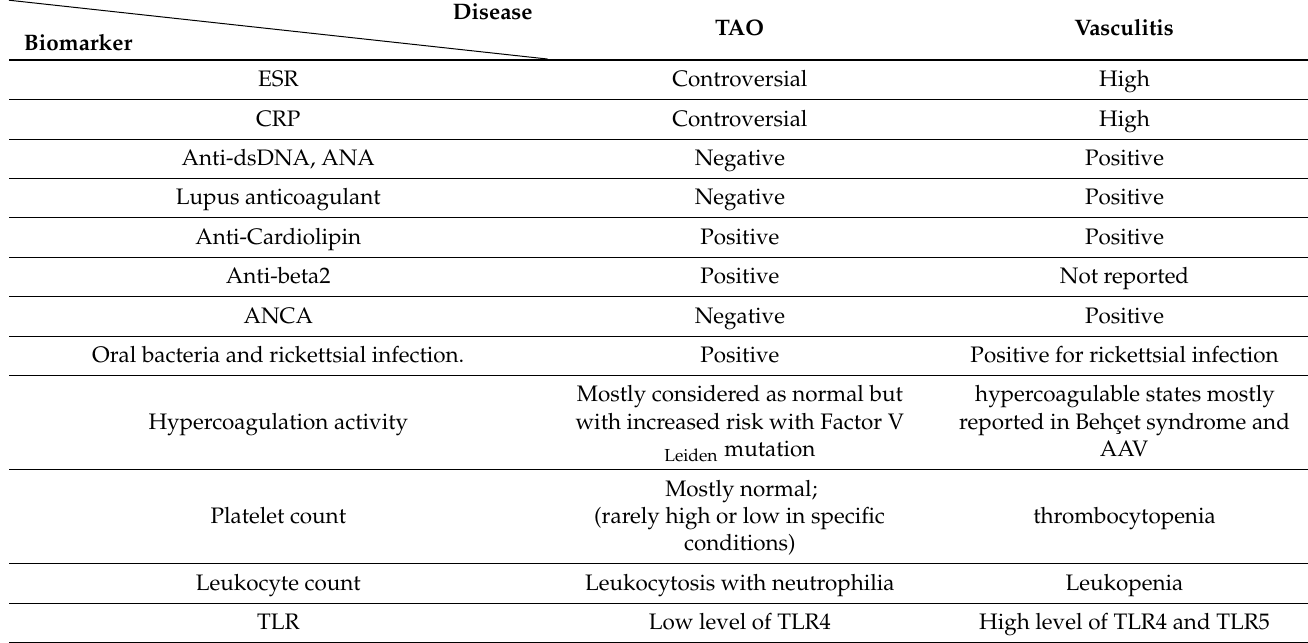
Table 8. Routine laboratory differential diagnostic tests for TAO and